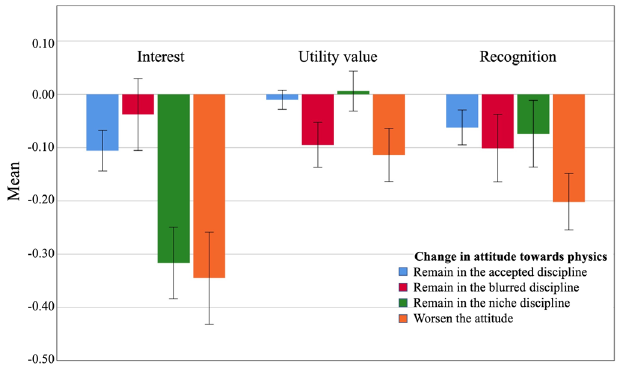
FIG. 9. Mean of the differences between the interest, utility value, and recognition raw scores after and before the remote distance instruction across the four categories of change in the attitude towards physics. Whiskers indicate standard deviation.